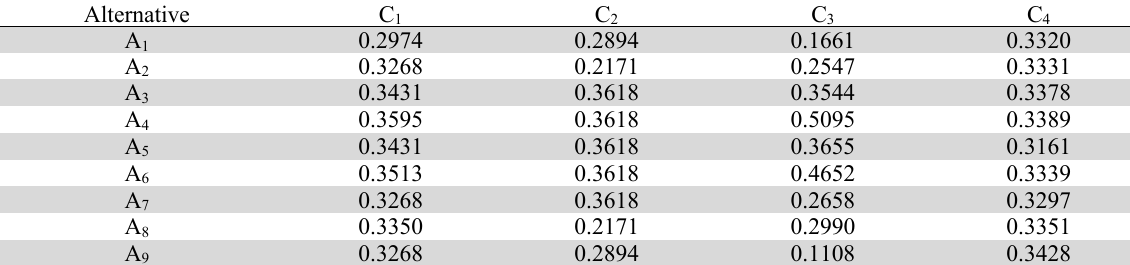
Normalized decision matrix for soluble oil selection problem Alternative